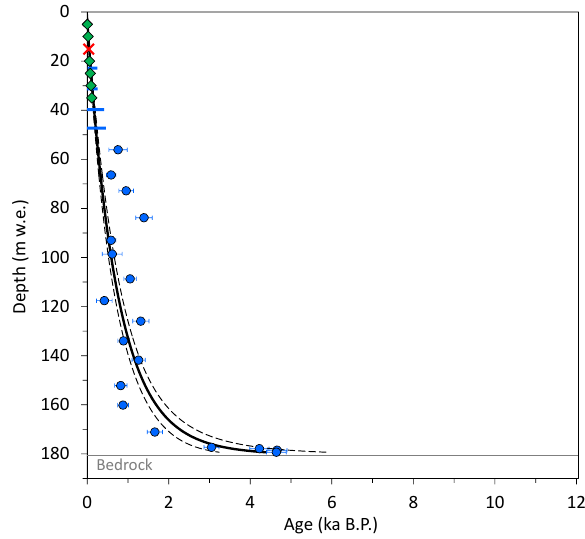
Figure 4. The depth–age relationship of the Chongce 216.6m Core 4. The dashed lines represent the 1 σ confidence interval of the 2p model fit (solid line). The red cross stands for the tritium horizon, green diamonds for the 210 Pb ages calculated at intervals of 5mw . e . (Fig. 3), and the blue dots for the calibrated 14 C ages with 1 σ error